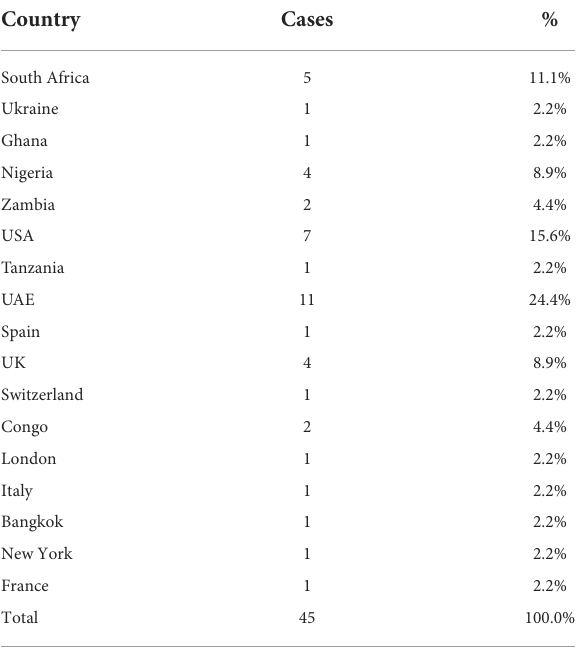
TABLE 4 Details of travel and vaccination history in Omicron cases in Rajasthan.